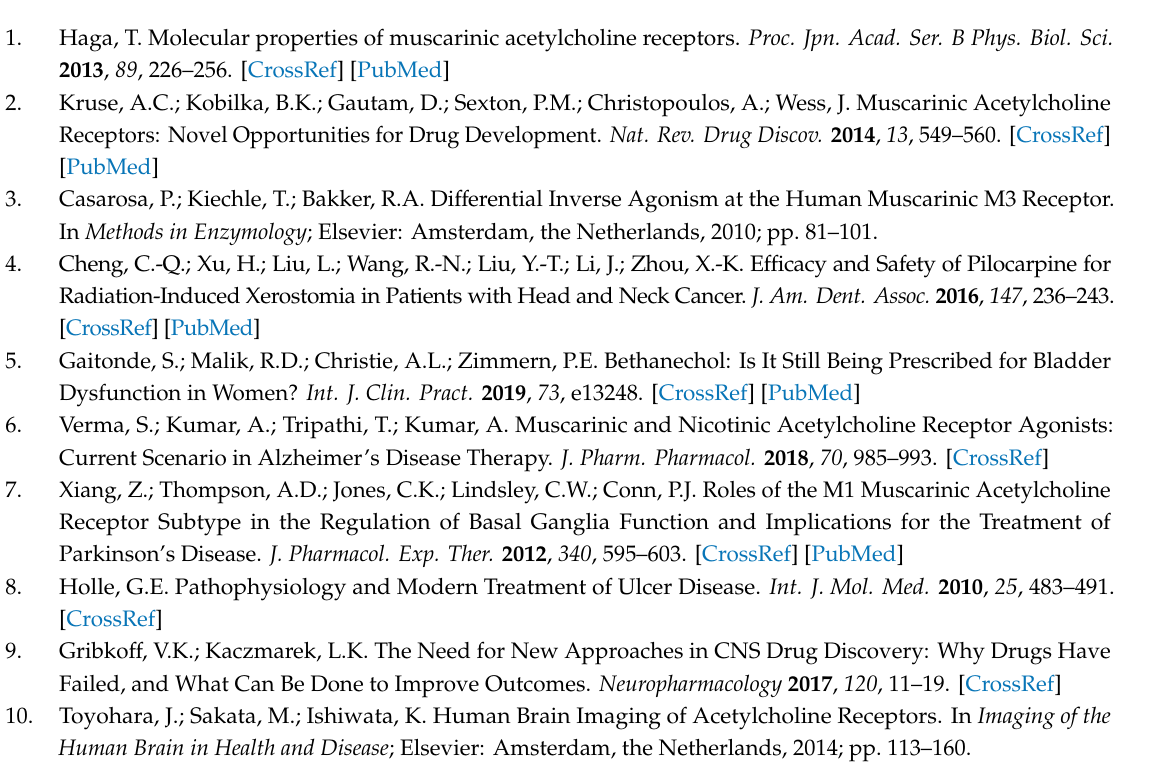
Figure S1: Exemplary competitive binding curves of 1 , 2 , and 3 on human mAChR M1 expressed on cell membranes of stably transfected CHO cells using [ N -methyl- 3 H]scopolamine methyl chloride. Values at 10 − 11 M and 10 − 10 M represent full binding in absence of competitor, Figure S2: Isocratic HPLC chromatograms of compounds 1 – 3 . 35–40% ACN in 25 mM NH 4 H 2 PO 4 bu ff er pH 9.3 at a flow of 1 mL / min, Figure S3: Chiral chromatography using a an AGP 0.3 cmØ × 5cm 5 µ M column operated with 2% IPA in 10 mM NH 4 Ac pH 5.8 at a flow of 0.5 mL / min, Figure S4: 1 H- and 13 C-NMR spectrum of 1 , Figure S5: 1 H- and 13 C-NMR spectrum of 2 . Figure S6: 1 H- and 13 C-NMR spectrum of 3